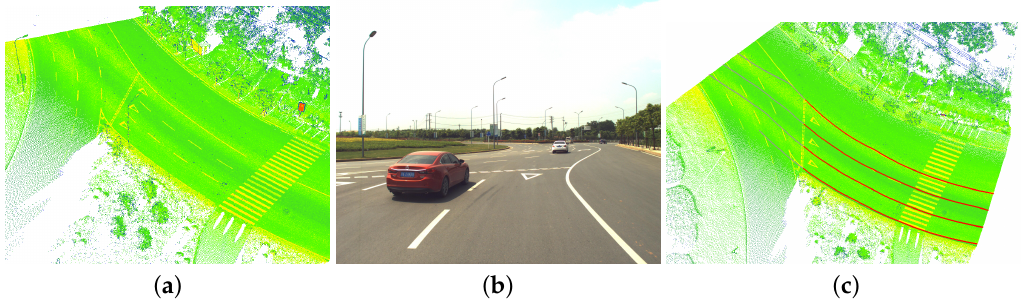
Figure 24. Error analysis: the junction. ( a ) The raw data of a junction where the vehicle enters the roundabout. ( b ) The corresponding MMS image. ( c ) The mapping result is presented in the colored point cloud, where the correct extractions are red, and the false positives are gray.